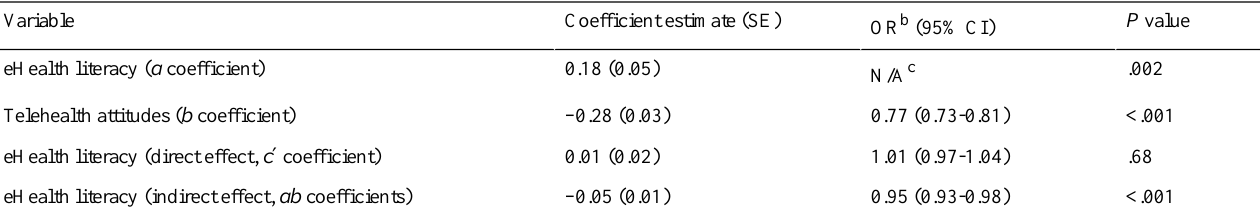
Table 3. Adjusted estimated effects based on mediation analysis conducted with linear and proportional odds regression models (n=294).